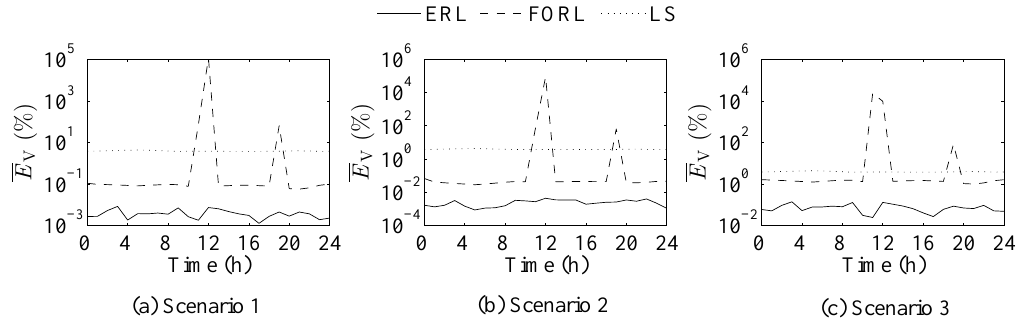
Figure 12. Mean voltage errors produced by the three algorithms in the different scenarios.